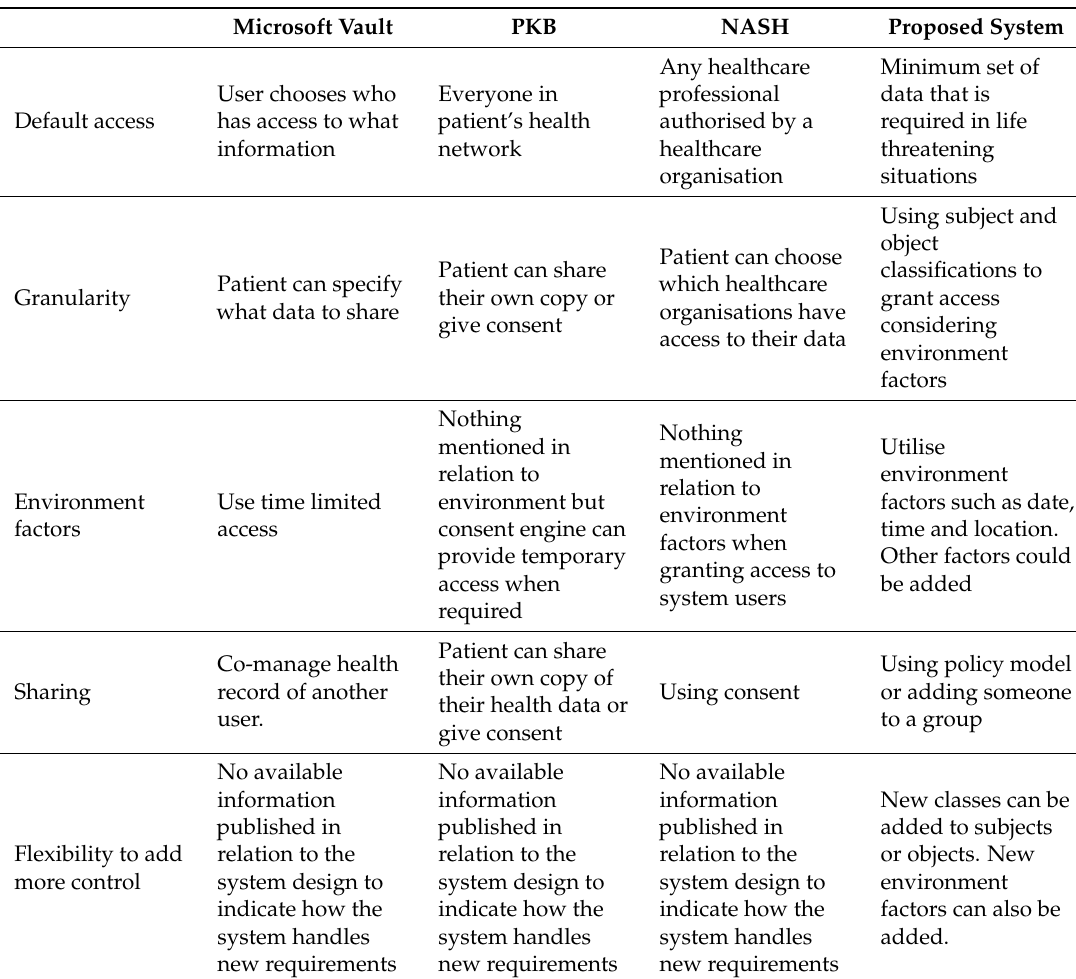
Table 1. Comparison of different healthcare data access control